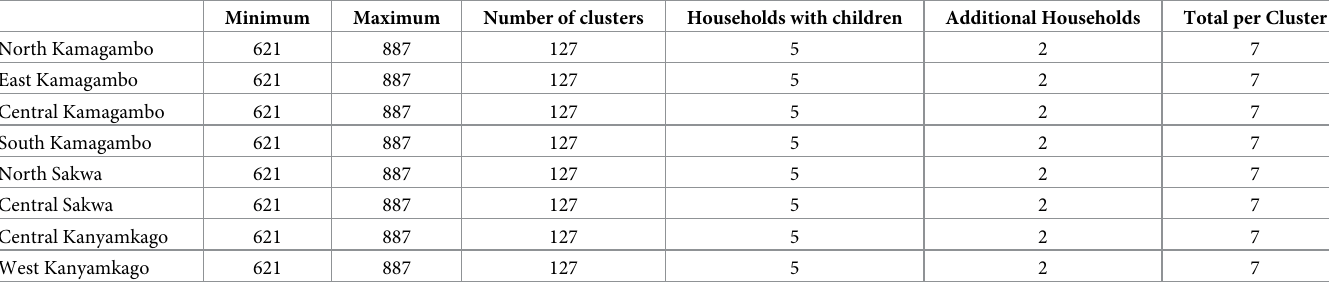
Table 2. Sample sizes for successive